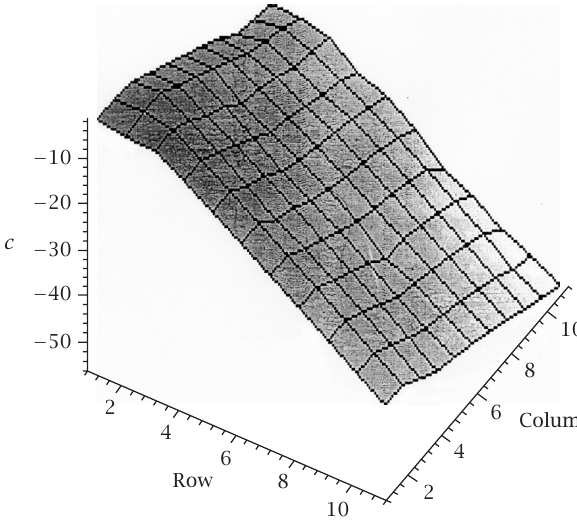
Figure 4.2 . The cluster concentrations c r,s at time t = 3 for n r = n s =